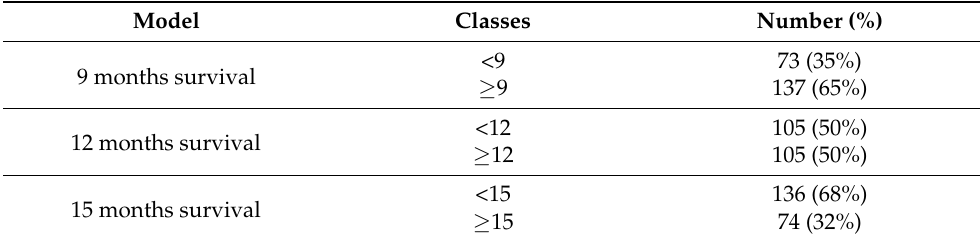
Table 3. Classes’ distribution before